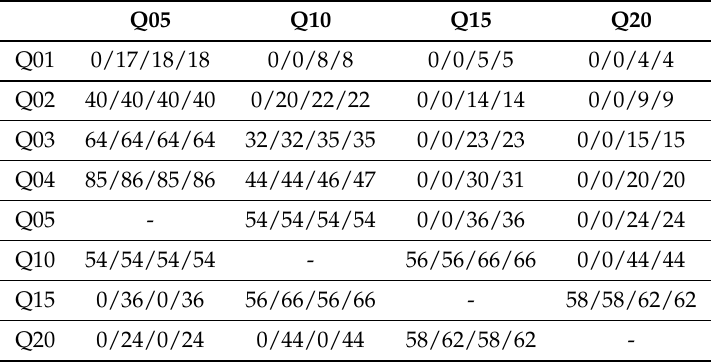
Table 6. Test results for similar plain text files with SiSe, part 2 (hash vs. hash/file vs. hash/hash vs. file/file vs. file).